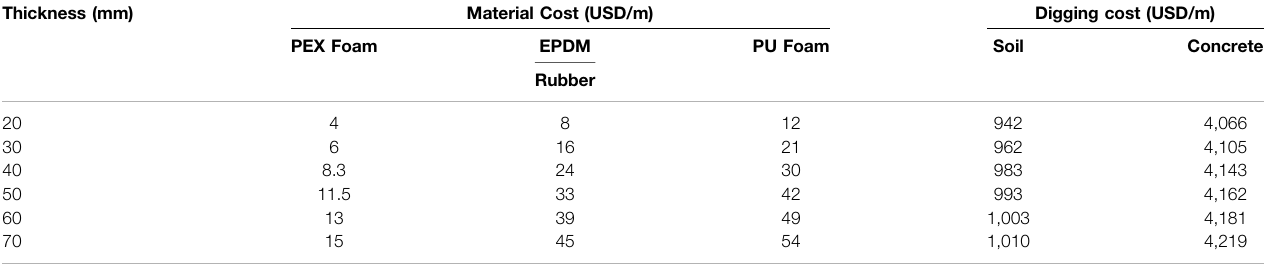
TABLE 6 | Estimated material and digging cost for different insulation materials with varying thickness. Thickness